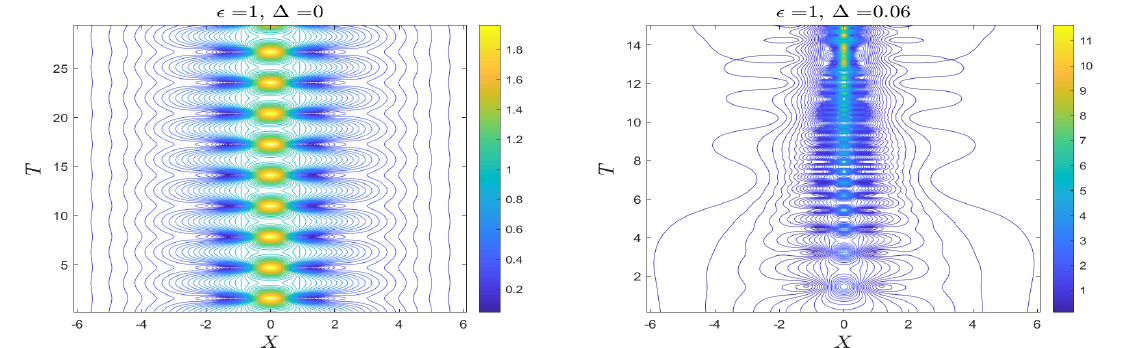
Figure 12. Case 3: The initial condition is (13) with γ = 0.5, (cid:101) = 1.0, M = 1 and ∆ = 0, ∆ = 0.06.